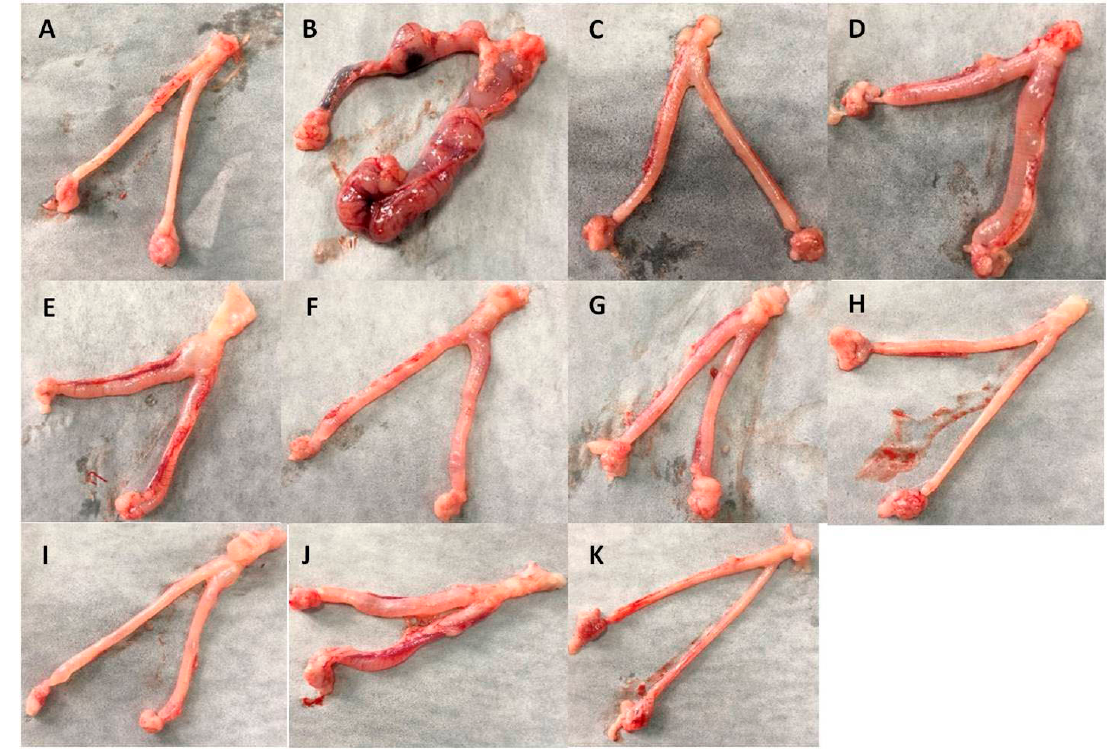
Figure 4. Morphological changes in the cervixes of SD rats treated with different extracts obtained from C. nudiflora . ( A ) Control group. ( B ) Model group. ( C ) XMS-treated group. ( D ) CNEH-treated group. ( E ) CNEL-treated group. ( F ) CNE-pH-treated group. ( G ) CNE-pL-treated group. ( H ) CNE-d H-treated group. ( I ) CNE-dL-treated group. ( J ) CNE-b H-treated group. ( K ) CNE-bL-treated group.